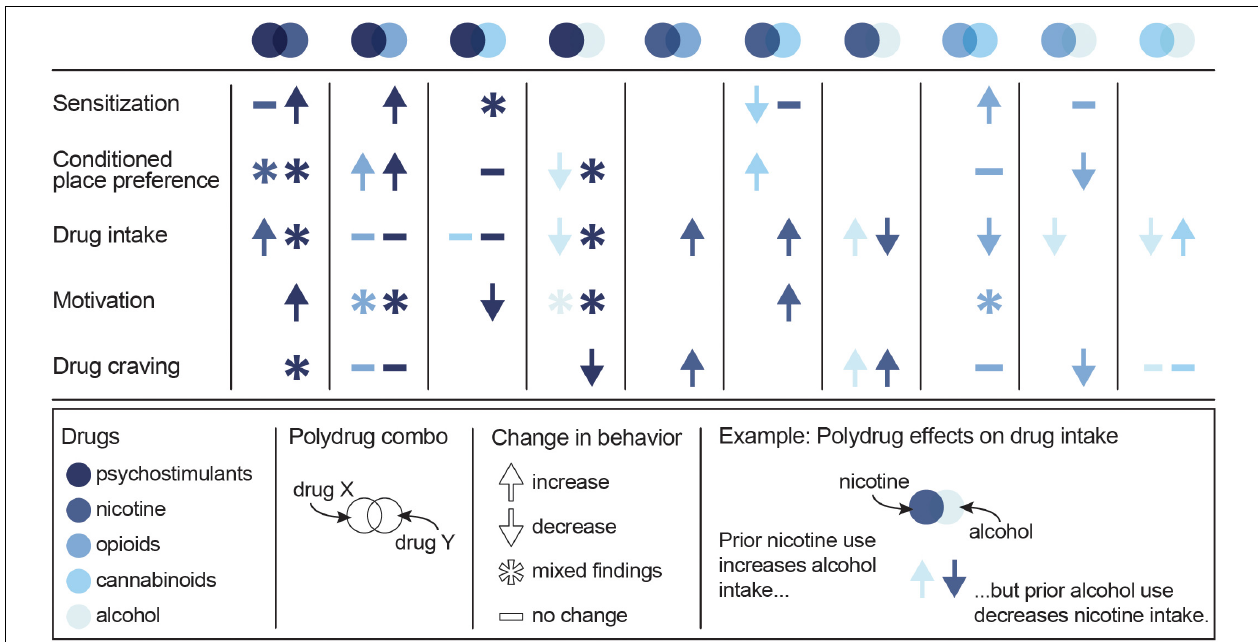
FIGURE 2 | Summary of the effects of specific polydrug combinations on assays of addiction-like behaviors. Studies are organized into X/Y polydrug combos (columns) and behavioral assays (rows), with subcolumns for the effect of drug Y on drug X (left subcolumn) and the effect of drug X on drug Y (right subcolumn). Symbols represent the net effect of the X/Y polydrug combo on a given behavior, with color depicting the specific drugs tested. Sensitization: locomotor sensitization; Conditioned place preference: acquisition, expression; Drug intake: self-administration; Motivation: progressive ratio, behavioral economics; Drug craving: reinstatement, cue reactivity. Data from Mello and Mendelson (1978), Mello et al. (1980), Mello et al. (2014), Huston-Lyons et al. (1993), Foltin et al. (1993), Aspen and Winger (1997), Ranaldi and Wise (2000), Valverde et al. (2001); De Vries et al. (2001), Parker et al. (2004); Solinas et al. (2005), Liang et al. (2006); Biala and Budzynska (2006), Ward et al. (2006); Panlilio et al. (2007), Panlilio et al. (2013), Winger et al. (2007), Lê et al. (2010), Lê et al. (2014), Levine et al. (2011), Cortright et al. (2011), Pomfrey et al. (2015), Maguire and France (2016); Mahmud et al. (2017), Fredriksson et al. (2017); Giasson-Gariépy et al. (2017), Griffin et al. (2017); Schwartz et al. (2018), Winkler et al. (2018); Manwell et al. (2019), Ponzoni et al. (2019), Crummy et al. (2020), and Stennett et al.